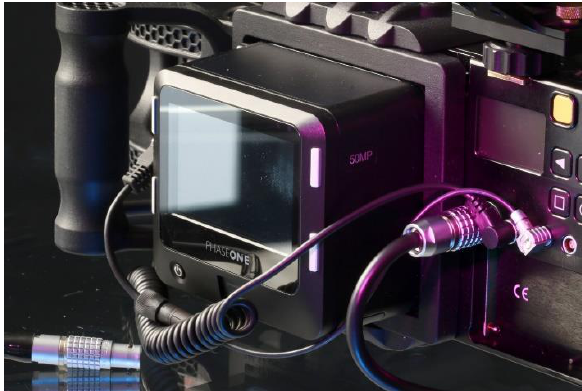
Figure 3. ALPA 12 FPS add|metric detailed view of digital back